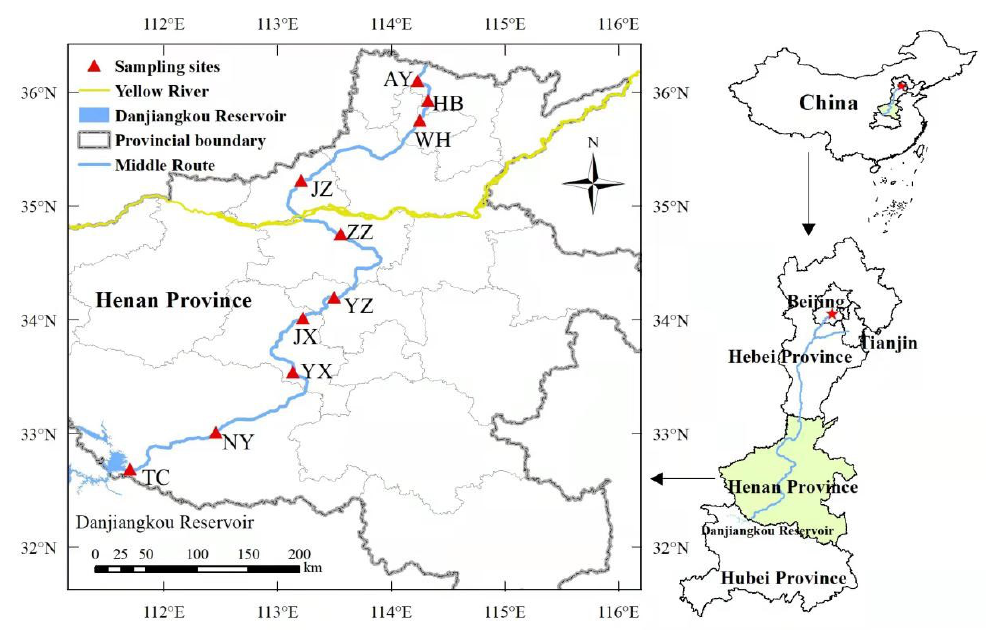
Figure 1. Locations of sampling in the MRP of the SNWD.